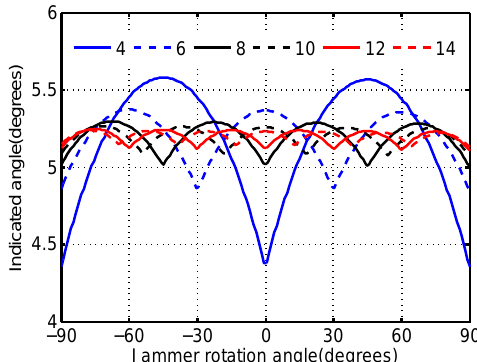
Figure 13. Monopulse-indicated angles of modified C-MRCJ with the optimal configuration for a range of antenna numbers when the jammer antennas rotate. The system parameters are a 1 = a 2 = a 3 = − 0.5 dB, φ 1 = φ 2 = φ 3 = 180 ◦